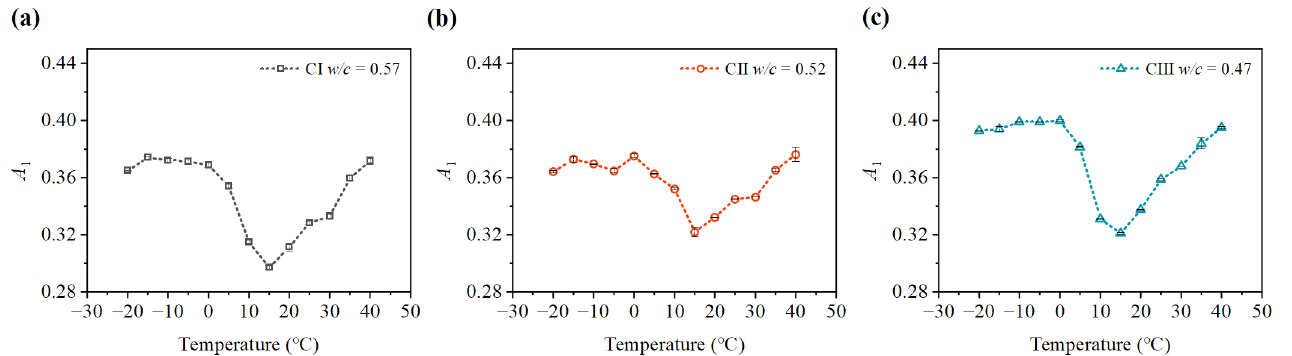
Figure 7. Variation of fundamental amplitude A 1 at different temperatures: ( a ) fundamental ampli-